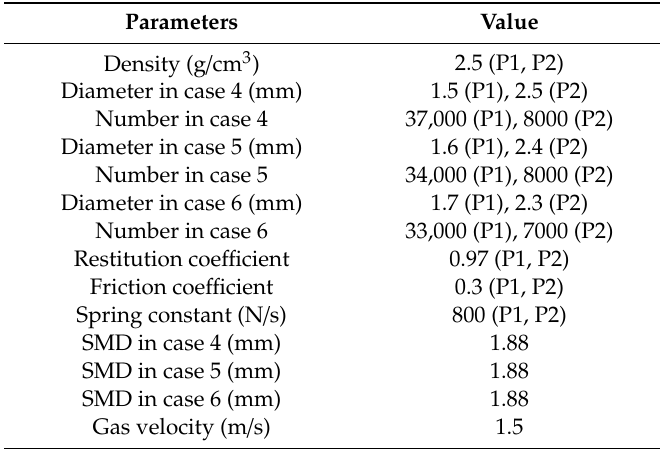
Table 4. Details of the gas-solid properties in the current simulation, P1 for the small particle and P2 for the large particle.